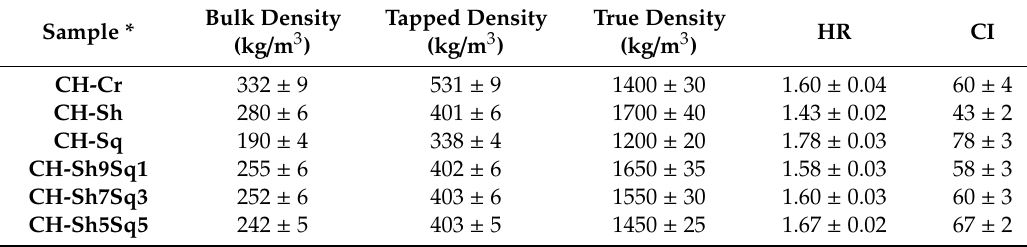
Table 1. True, bulk and tapped densities, HR, and CI of CHs from di ff erent sources and their mixtures. Sample